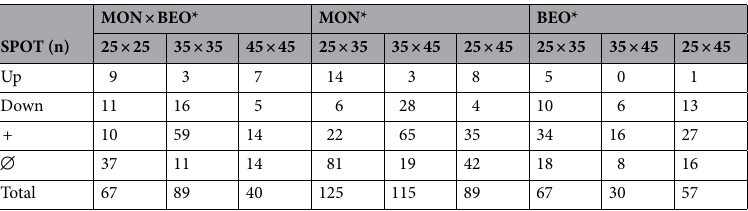
Table 1. Differentially expressed spots in Nellore beef cattle cecum fed with diets containing increasing starch levels (25, 35, and 45%) and additives (Monensin, Blend of essential oil + exogenous α-amylase). UP up-regulated spot , Down down-regulated spot , + spot present in the first group in relation to the second, ∅ spot absent in the first group in relation to the second. * P ≤ 0.05